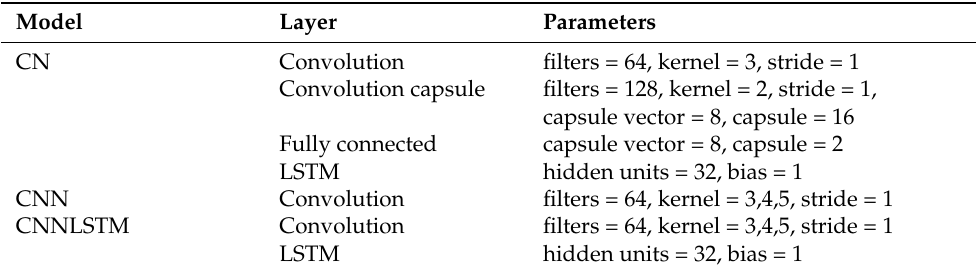
Table 4. Parameters of existing deep learning